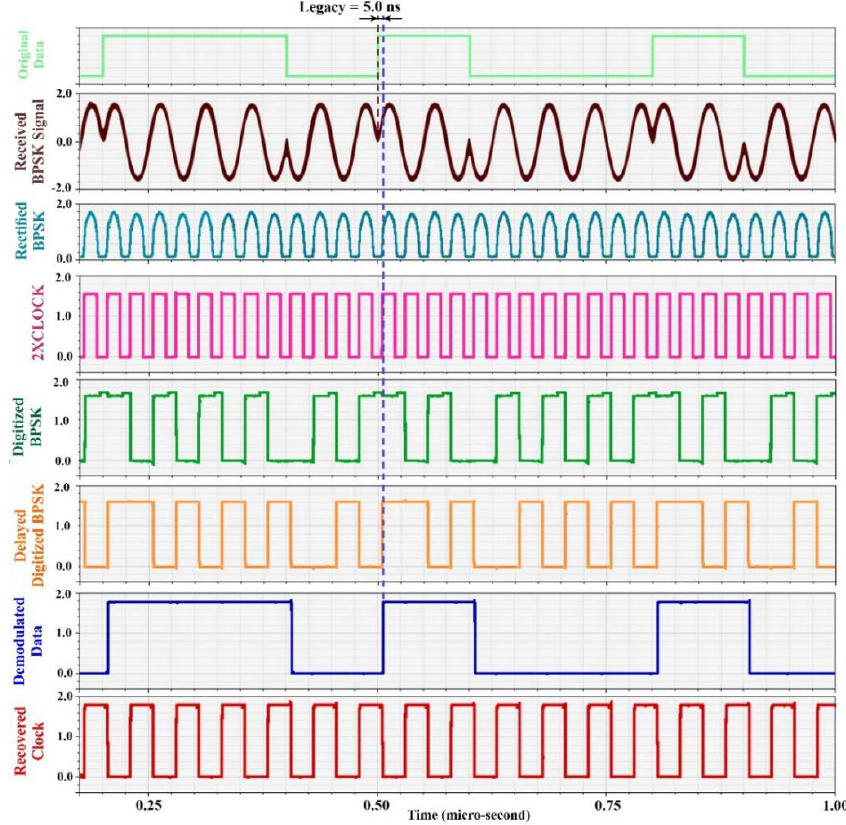
Figure 7. Transient response of the presented BPSK demodulator at 20 MHz carrier frequency.